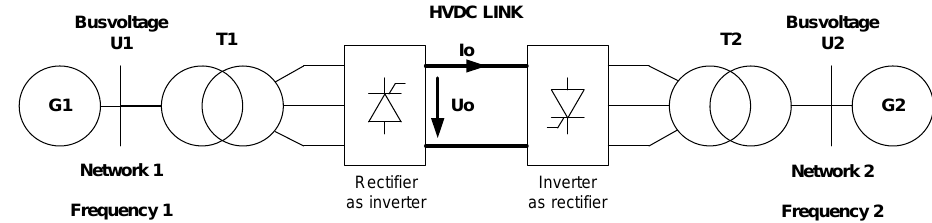
Figure 1. Typical layout of a point-to-point high-voltage direct current (HVDC) power transmission system.